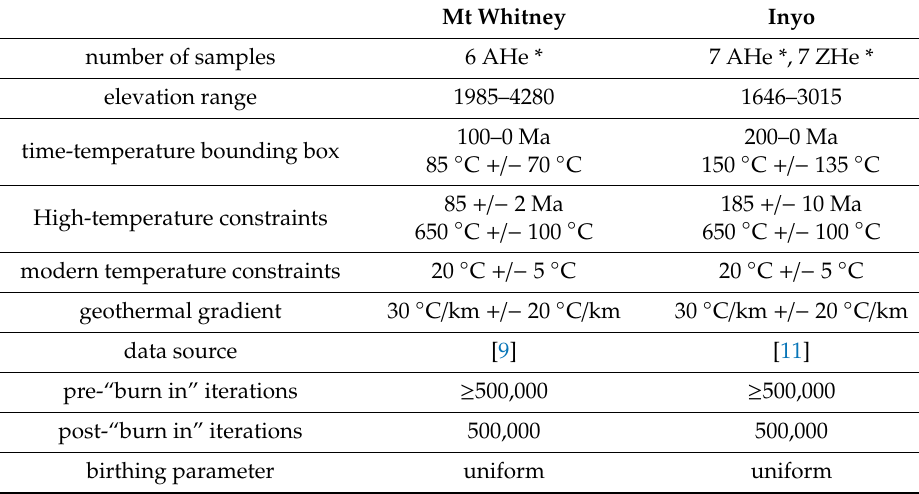
Table 2. Data interpretation and reporting